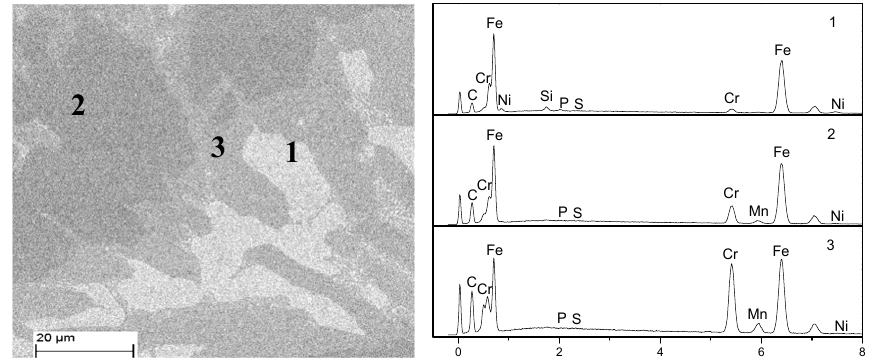
Figure 9. Scanning electron microscope (SEM) and energy-dispersive spectrometry (EDS) analysis results of ferroalloy.